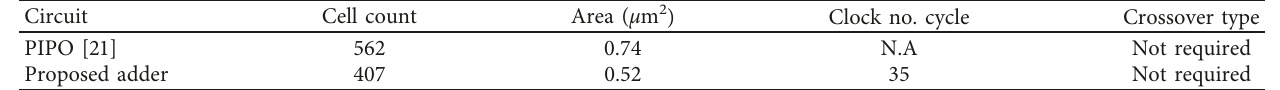
Table 4: Comparison of the proposed 8-bit PIPO with the previous works.